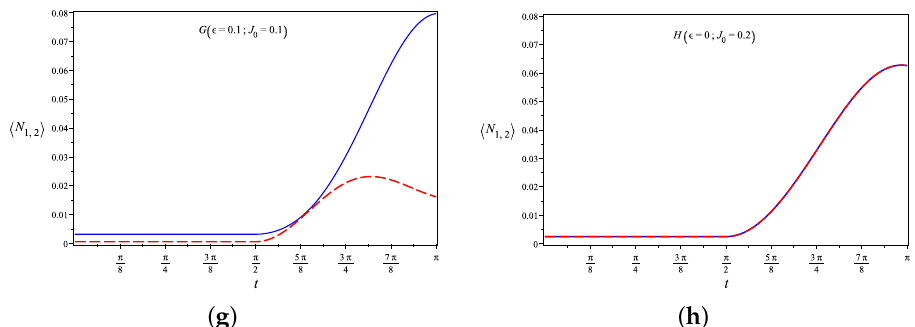
= 1.01 and different values of the quench parameter (cid:101) Figure 5. The dynamics of VE for fixed ω 2 0 and coupling J 0 displayed at the top of the figures. The time dependent frequencies ω 1,2 ( t ) of the coupled oscillators are given in Equation (22) and are, thus, determined by the parameters ω 0 , (cid:101) . The blue solid line corresponds to (cid:104) N 1 (cid:105) , and red dashed line corresponds to (cid:104) N 2 (cid:105)